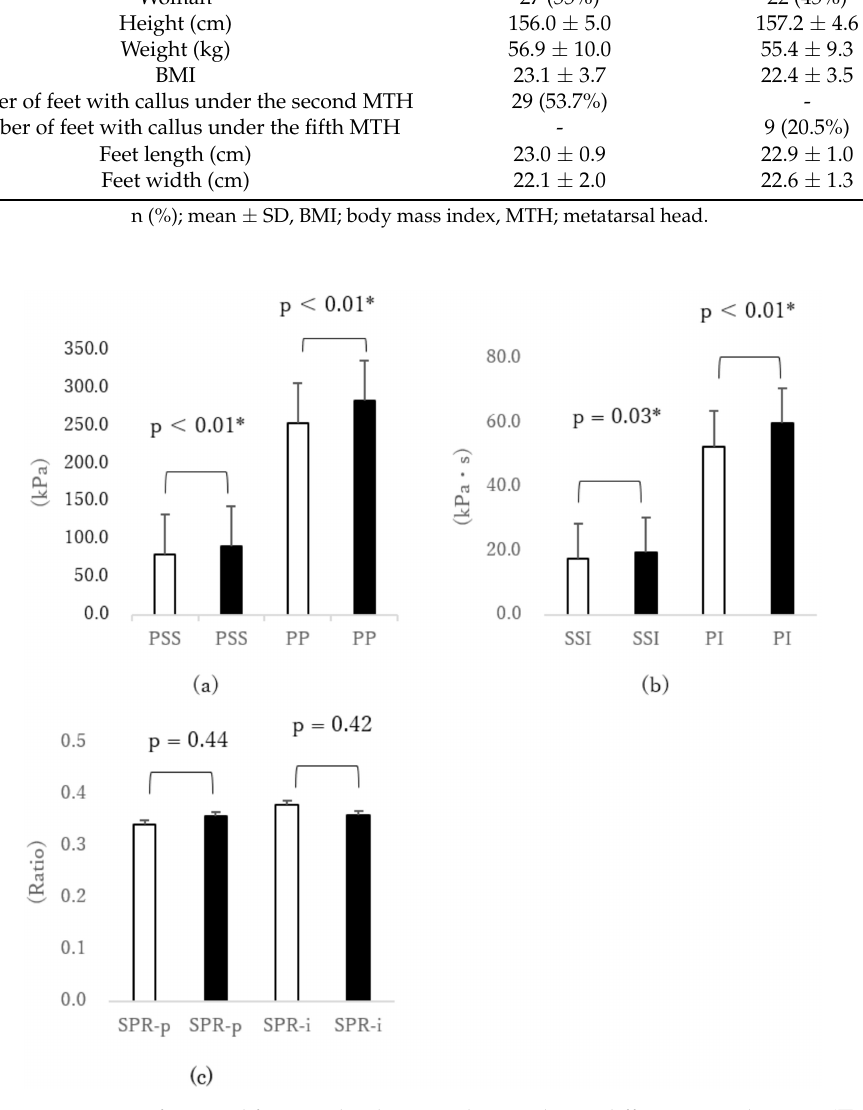
Figure 1. Comparison of external force under the second MTH due to differences in shoe size ( (cid:3) fit size vs. (cid:4) 1-cm larger size). ( a ) Peak normal stress (pressure) (PP) and peak shear stress (PSS), ( b ) normal stress (pressure) time integral (PI) and shear stress time integral (SSI), and ( c ) shear stress/normal stress (pressure) ratio of peak value (SPR-p) and shear stress/normal stress (pressure) ratio of time integral value (SPR-i). * p < 0.05 paired t -test. Error bar was standard error (SEM). MTH: metatarsal